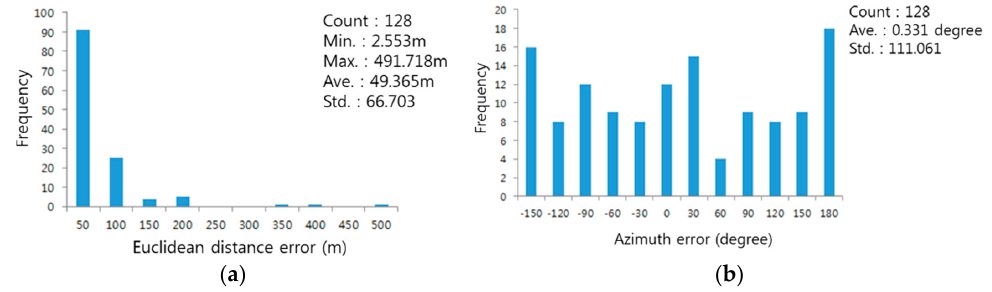
Figure 2. ( a ) Euclidean distance error histogram; ( b ) azimuth error histogram.